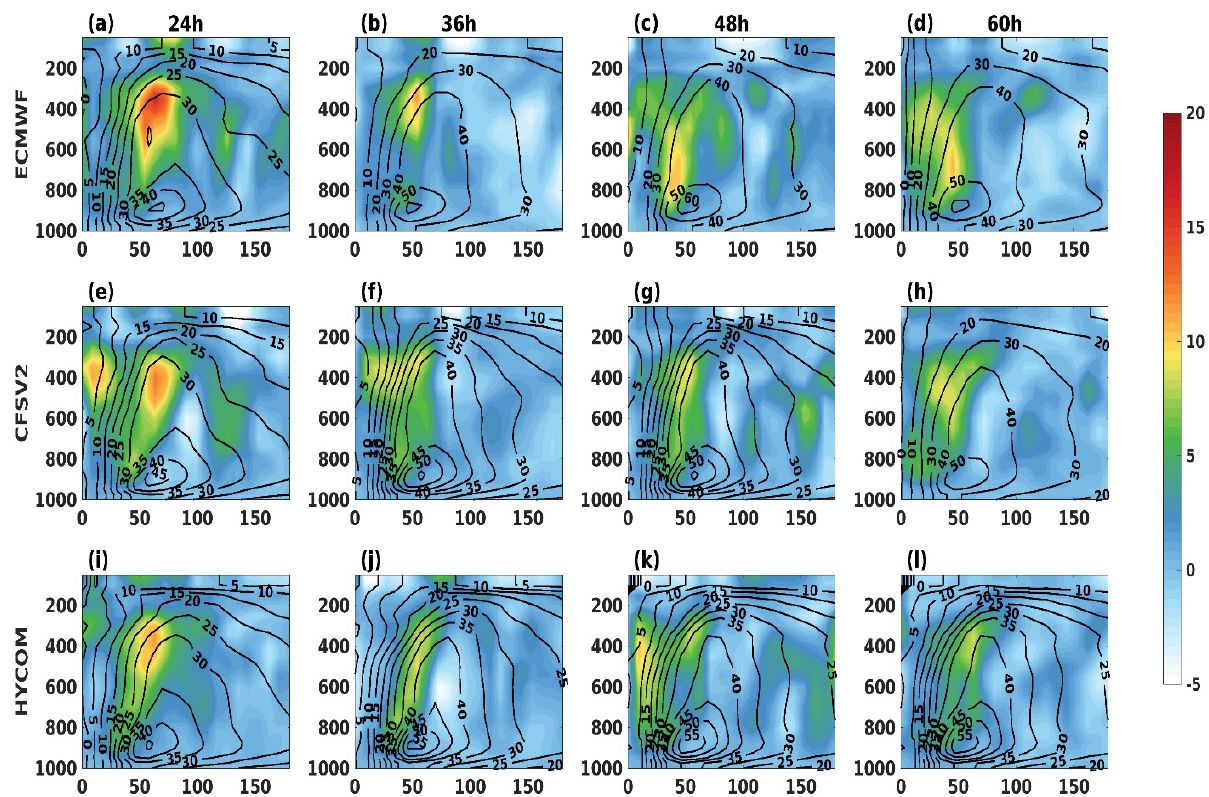
Figure 4. Azimuthally averaged pressure-radius distributions of diabatic heating (K.h −1 . shading) and tangential wind (m.s −1 , contour) for all three experiments (( a – d ) ECMWF, ( e – h ) CFSV2, ( i – l ) HYCOM) at 12 h intervals between 24 and 60 h.